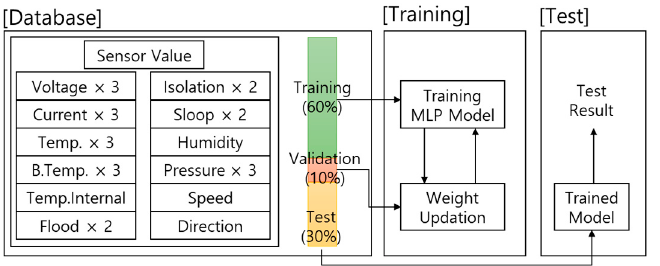
Figure 6. Data set configuration and MLP model training, validation, and test process.